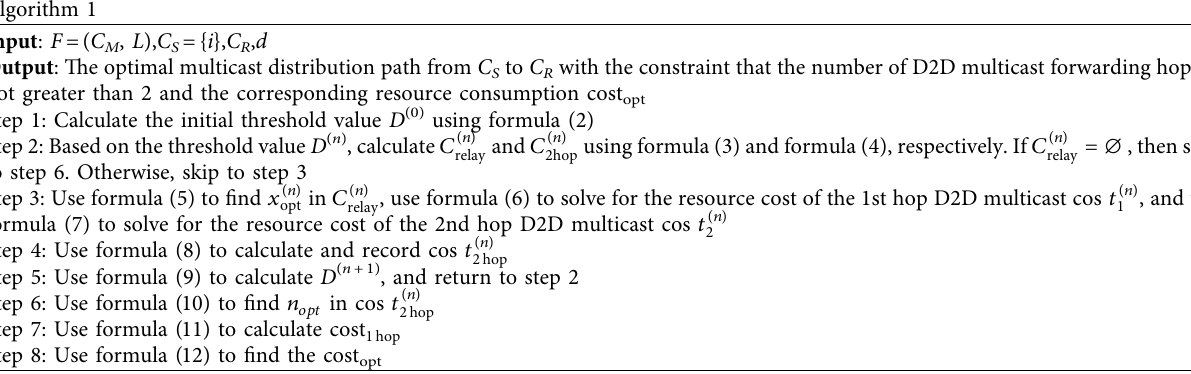
Table 1: D2D multicast cooperative distribution algorithm based on multihop relay. Algorithm 1